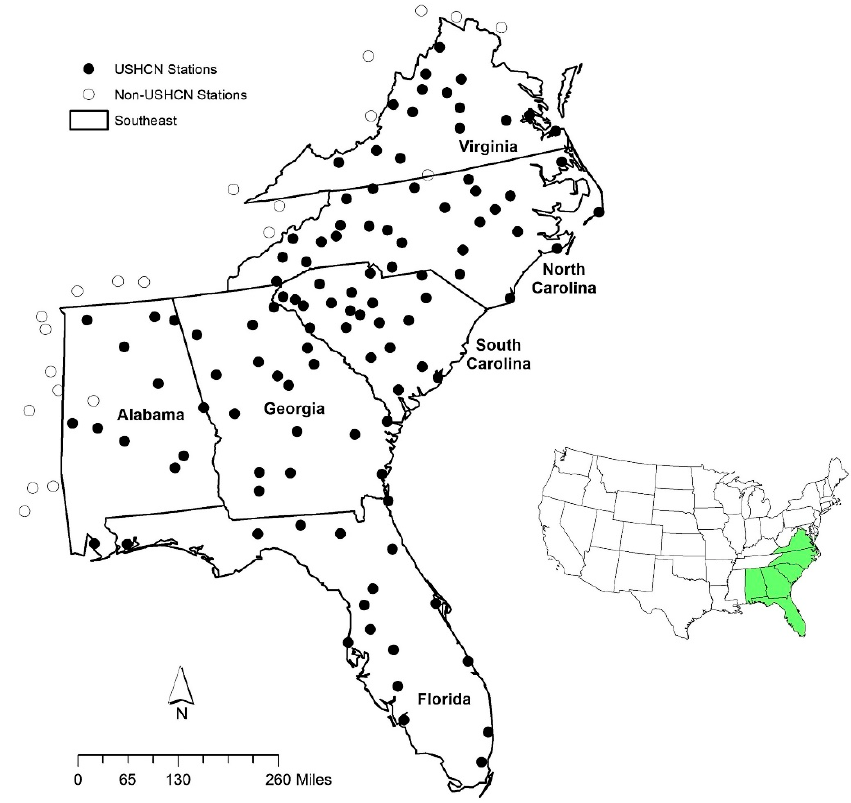
Figure 1. Study area (the Southeast, as defined by NOAA) and climate stations used in the study. The inset map shows the location of the study area within the United States of America.